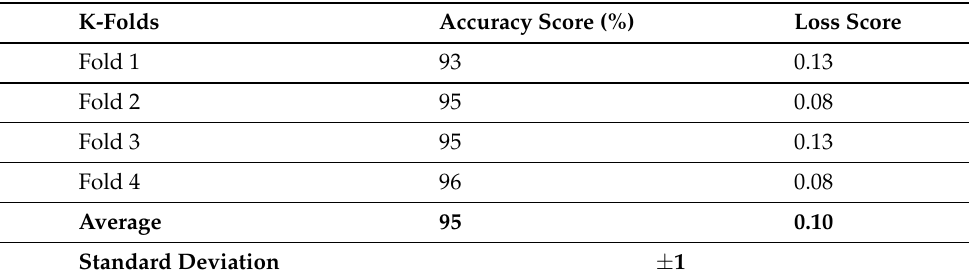
Table 9. The performance validation analysis of the novel proposed approach based on the k-fold cross-validation technique.